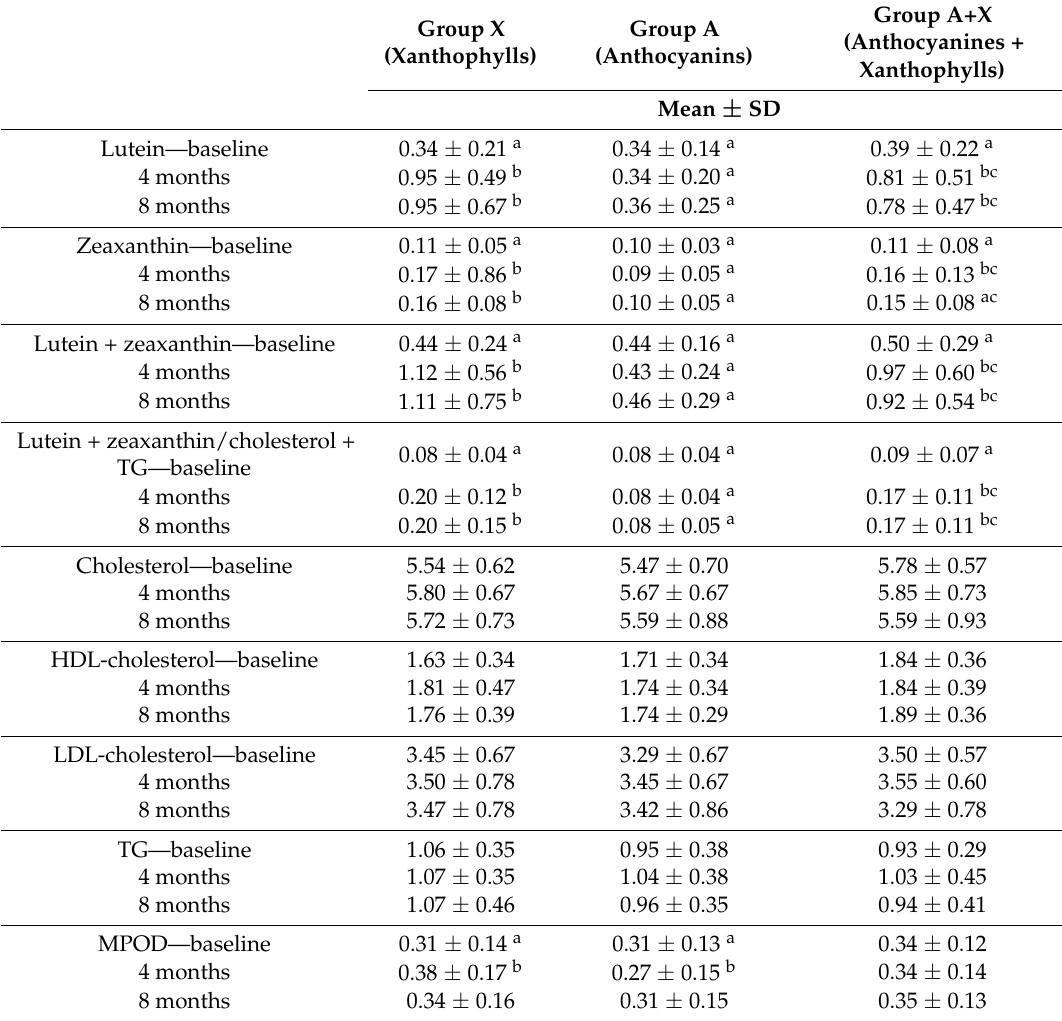
Table 2. Lutein, zeaxanthin, and lipid serum concentrations and MPOD at baseline and after 4 and 8 months of